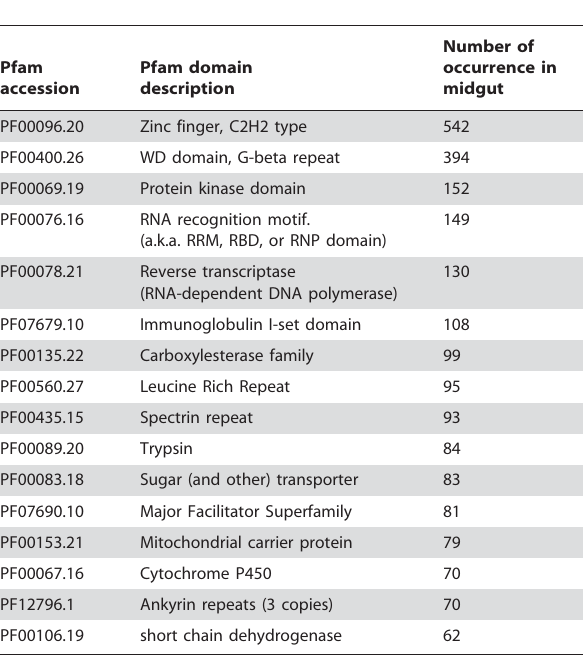
Table 3. Top Pfam domains identified in Chilo suppressalis midgut